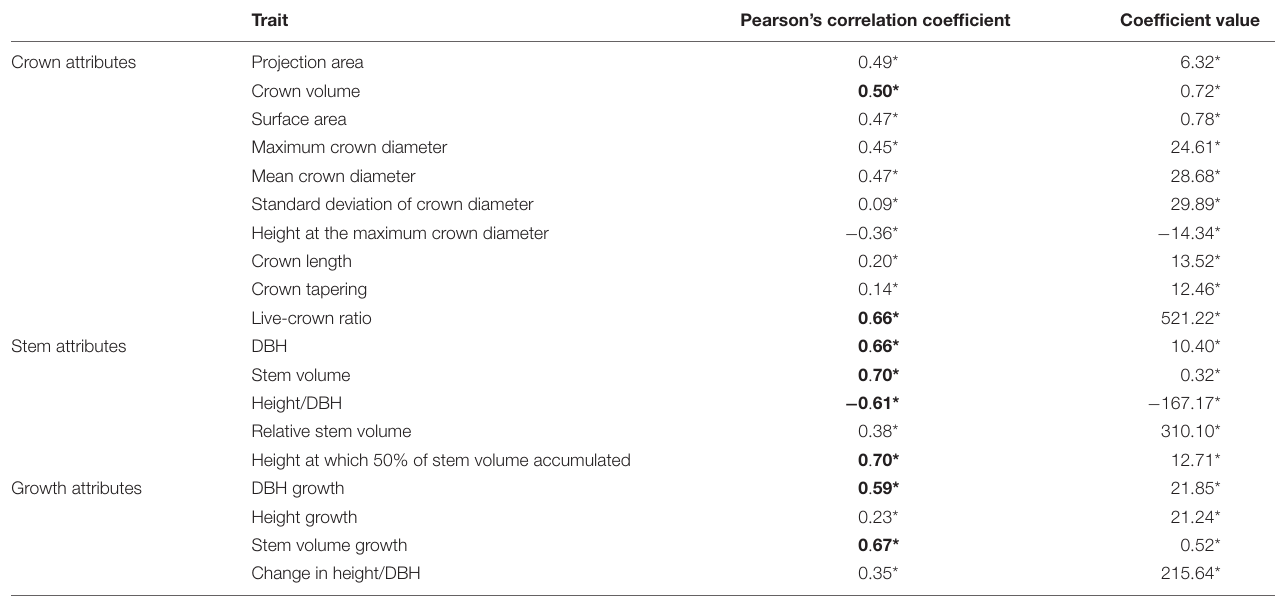
TABLE 4 | Pearson’s correlation coefficients between SAHMC diameter and crown, stem, and growth attributes and also coefficient value from the nested two-level linear mixed-effect models where each trait was independently included as a single predictor variable against SAHMC.